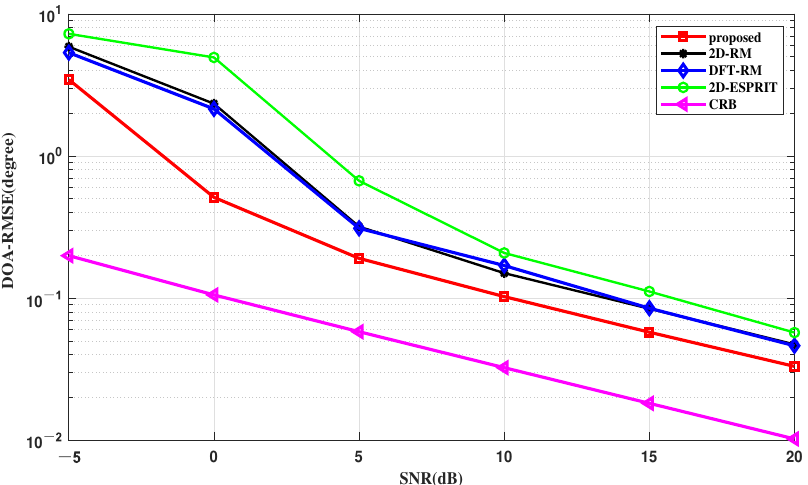
Figure 6. RMSE of the DOA estimation versus